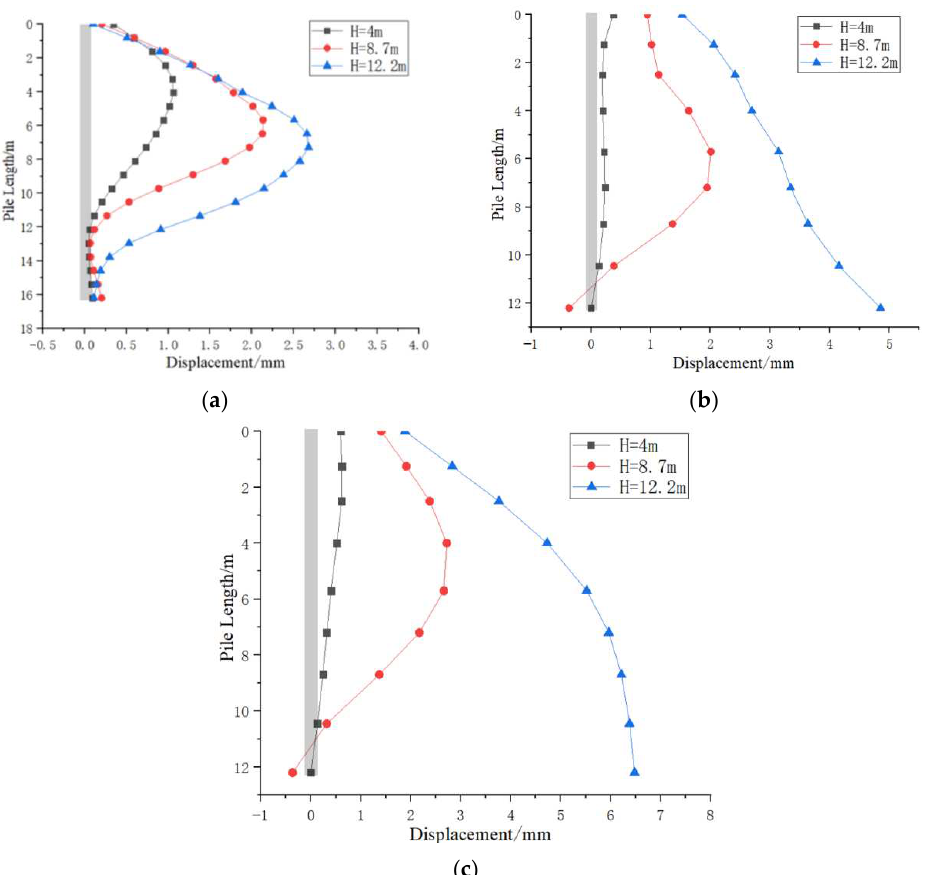
Figure 9. Horizontal displacement curve of supporting pile. ( a ) Horizontal displacement curve of pile Z1; ( b ) horizontal displacement curve of pile Z2; ( c ) horizontal displacement curve of pile Z3.